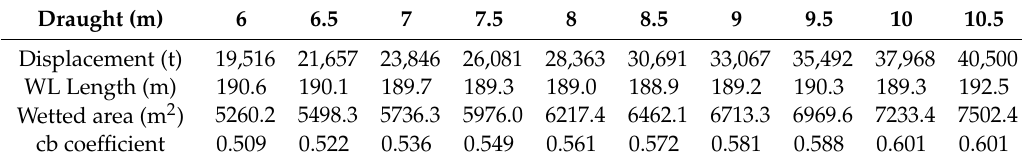
Table 4. Basic parameters of vessel form at design maximum draft value cb = 0.60.